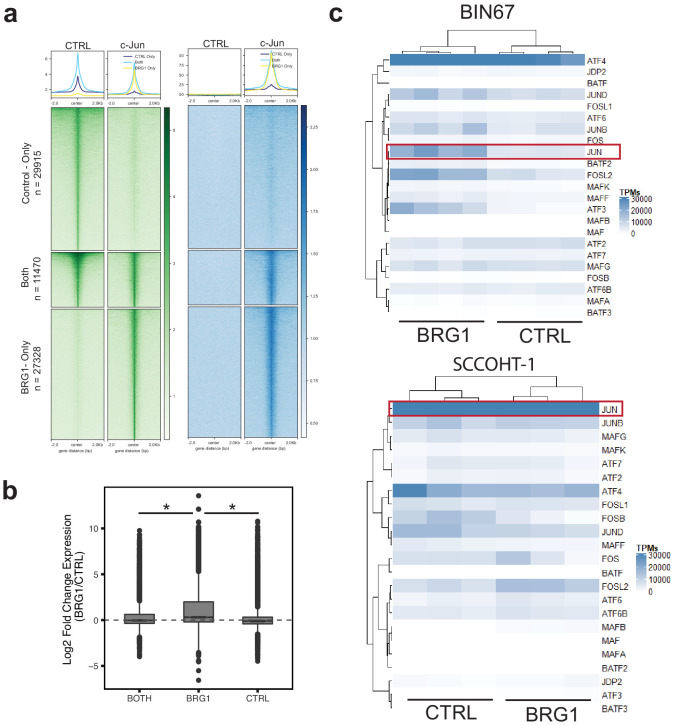
c-Jun is redistributed in SCCOHT-1 following BRG1 reexpression.(a) CUT and RUN signal of c-Jun and BRG1 in SCCOHT-1 cells reexpressing BRG1 at peaks that are present only in cells lacking BRG1 n = 29,915, present only in cells expressing BRG1 n = 27,328, or found in both conditions n = 11470. (b) Expression of genes assigned to peaks found in each of the three previous categories. pValues are BRG1-Both. = 4.35e−63, BRG1-CTRL, 3.63e−168 by Wilcoxon signed-rank test. (c) Length scaled transcripts per million for AP-1 family members in BIN67 and SCCOHT-1 cells. Source data is available in Figure 4—figure supplement 1—source data 1.
Figure 4—figure supplement 1—source data 1.Raw data for Figure 4—figure supplement 1.